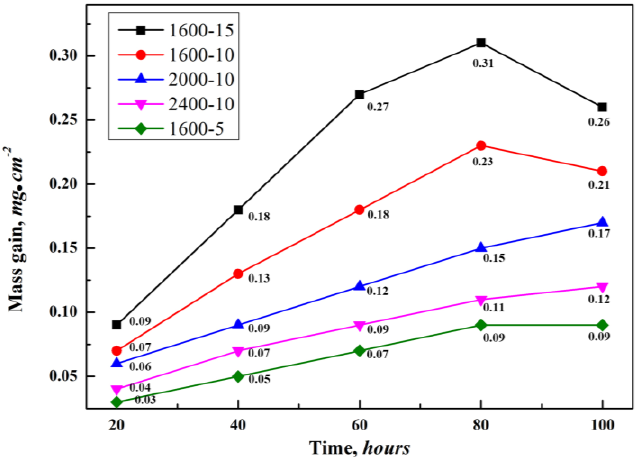
Figure 12. Mass gain variations of the samples under high-temperature oxidation for 100 h.